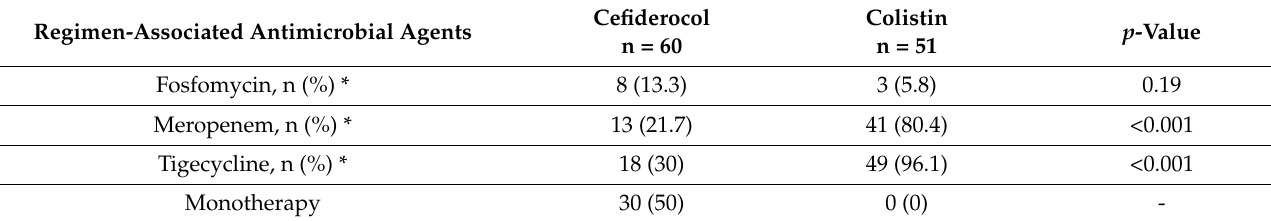
Legend for Table 2: n = number, % = percentage. * Cefiderocol and colistin in combination could have been combined with more than one antibiotic (see details in the Results section). Of the 36 patients with an ongoing COVID-19 infection, 13 patients died (27.7%). We